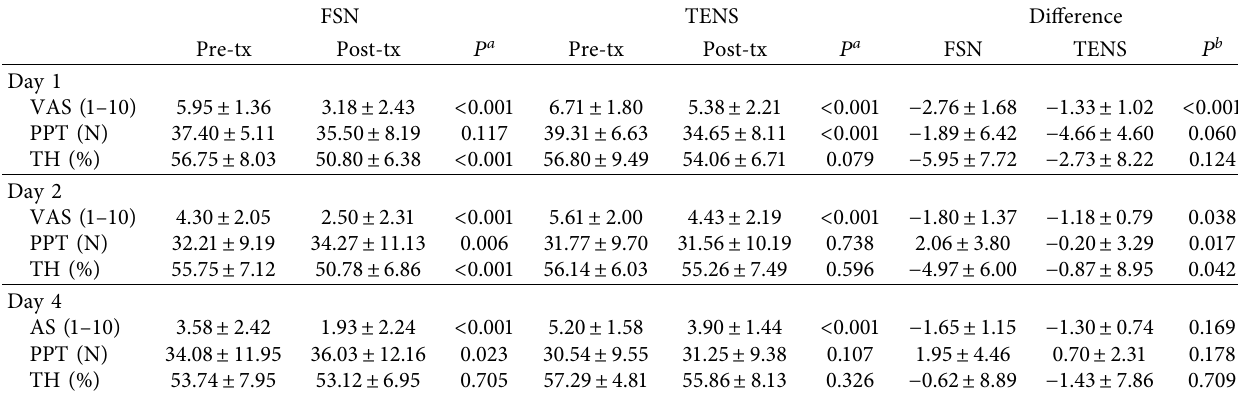
Table 2: Immediate effects of FSN and TENS groups on VAS, PPT, and